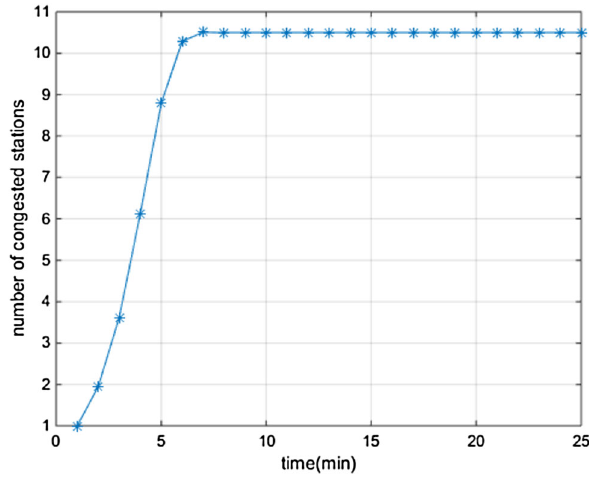
Fig. 4 Process of congestion propagation